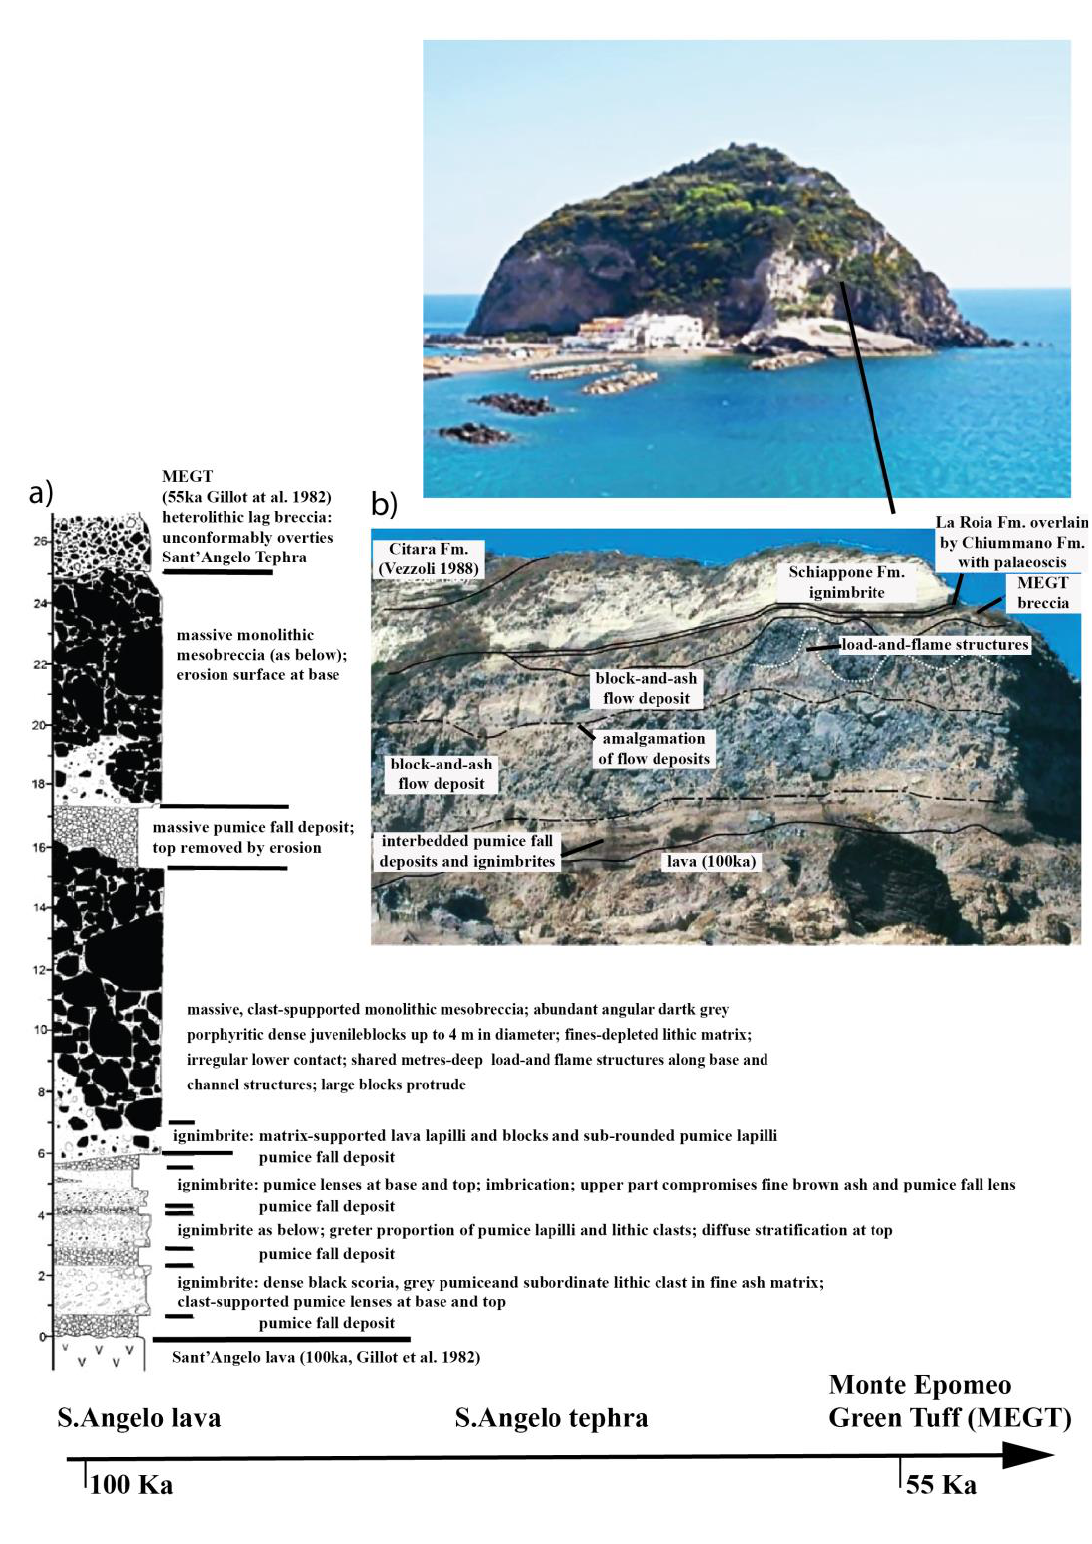
Figure 4. The S. Angelo tephra of Ischia (modified after Brown et al. [23]) ( a ) stratigraphic column of the S. Angelo tephra. ( b ) Interpreted outcrop data showing the stratigraphic relantionships of the tephra and adjacent